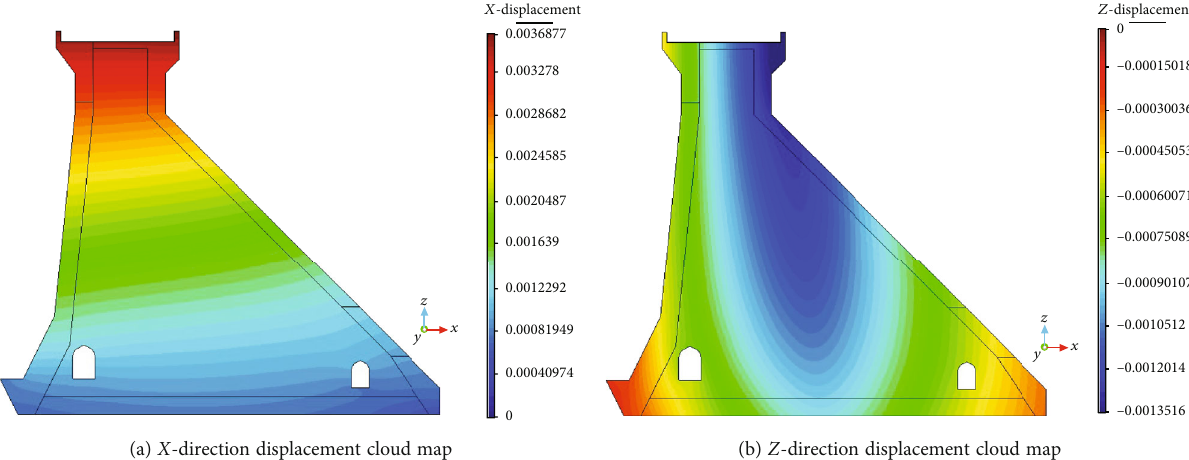
Figure 5: Displacement cloud diagram of dam retaining section under static and dynamic superposition (static+dynamic) (m).